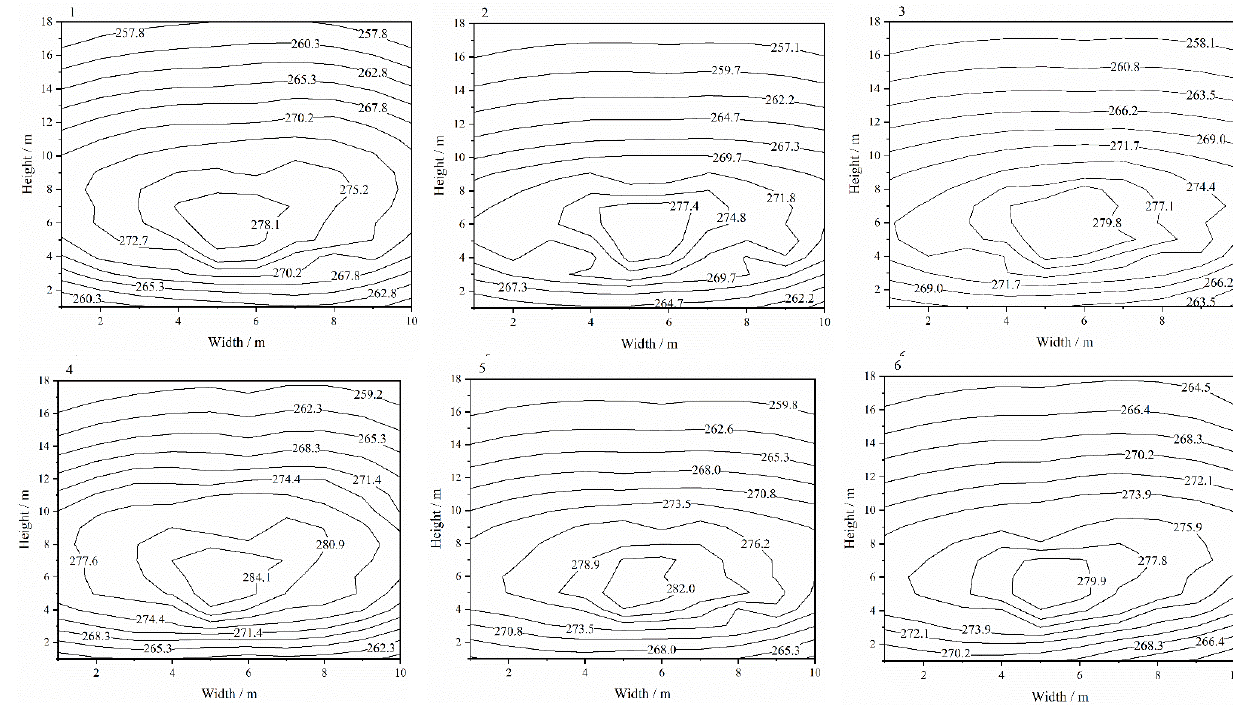
Figure 5. Distributions of metal temperature (°C) on the front wall. 1 – 3 : case 1 –case 3 , 4 – 6 : case 4 – case 6 .